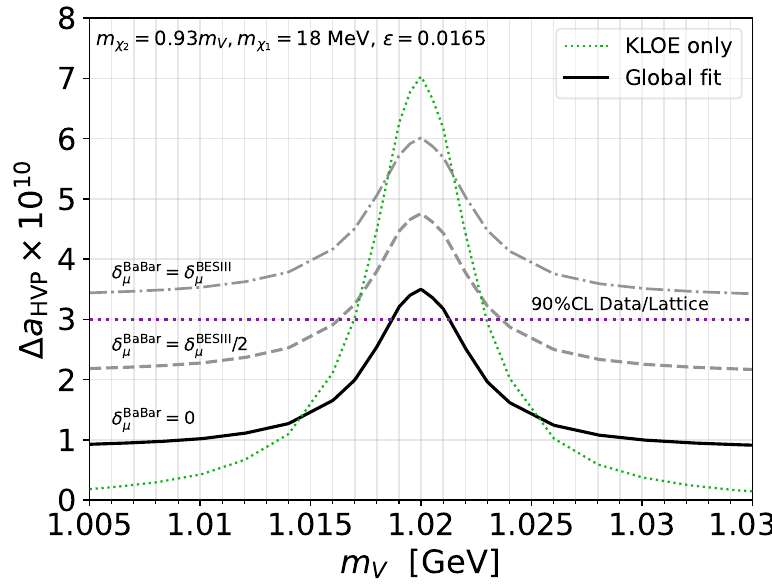
as a function of m for a dark photon model Figure 3 . Theoretical prediction for the shift in a LO , HVP V µ with m = 18 MeV, m = 0 . 93 m , α = 0 . 5 and (cid:15) = 0 . 0165 , which leads to δ KLOE12 . ∼ δ BESIII χ 1 χ 2 V D µ µ The dotted green line shows the combined KLOE result, while the thick black curve includes all the measurements, assuming negligible shifts on BaBar results. The dashed grey lines indicate the effect of an hypothetical shift in BaBar δ BaBar = δ BESIII (top) and δ BaBar = δ BESIII / 2 (bottom). Above µ µ µ µ the dashed purple line the BMW lattice result and the data-driven analysis agree at better than the 90%